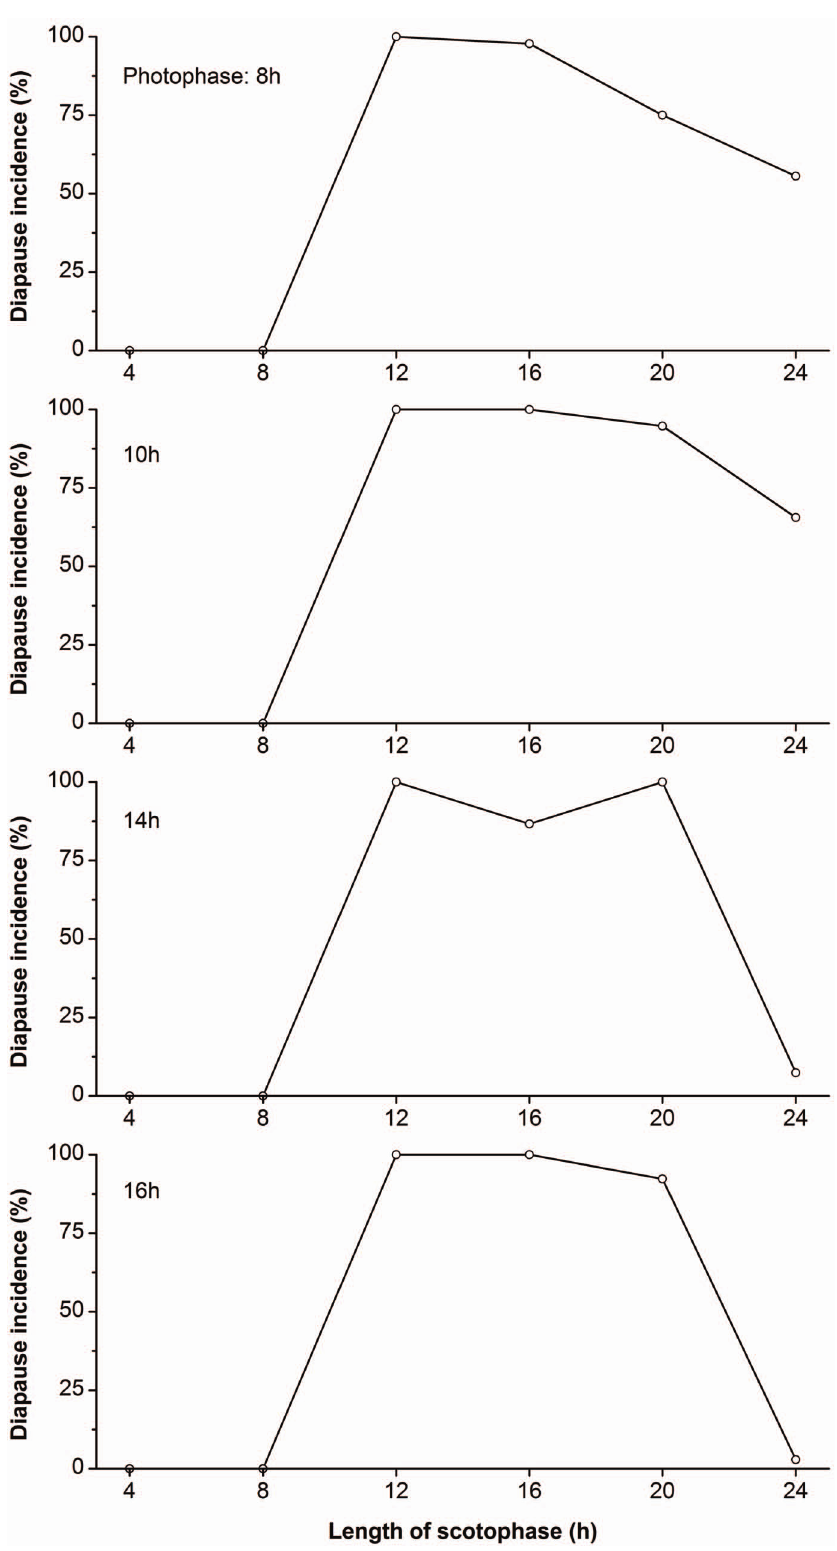
Figure 2. Photoperiodic response curves for the induction of diapause in H.cunea under non-24 h light–dark cycles at 28 u C. The length of photophase (top left of each panel) was held constant and the scotophase was changed in each experiment (X-axis). (3 replicates, each of at least 30 individuals/treatment; total n=32–200 for each point).